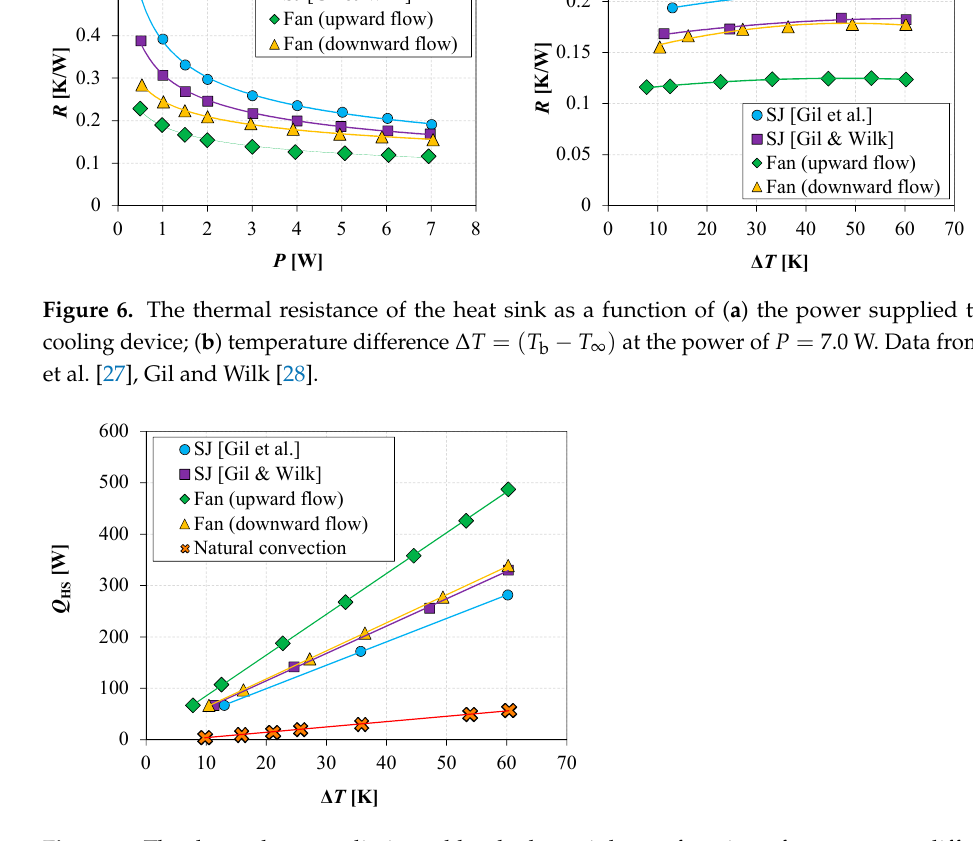
Figure 7. The thermal power dissipated by the heat sink as a function of temperature difference ∆ T = ( T − T ∞ ) at the power of P = 7.0 W. Data from: Gil et al. [27], Gil and Wilk b